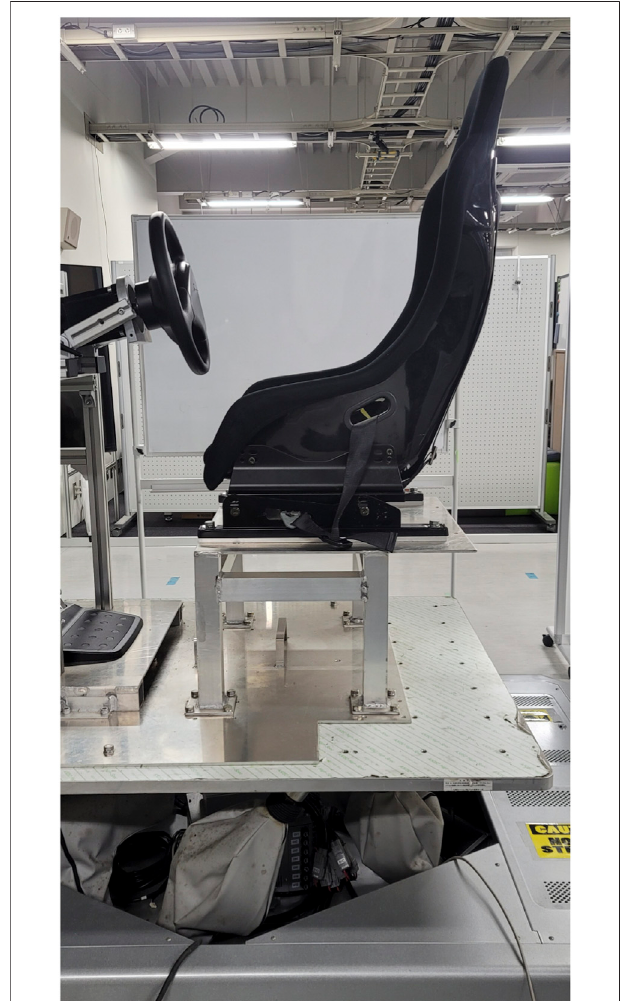
FIGURE 2 | Chair attached to the vibrating device for the